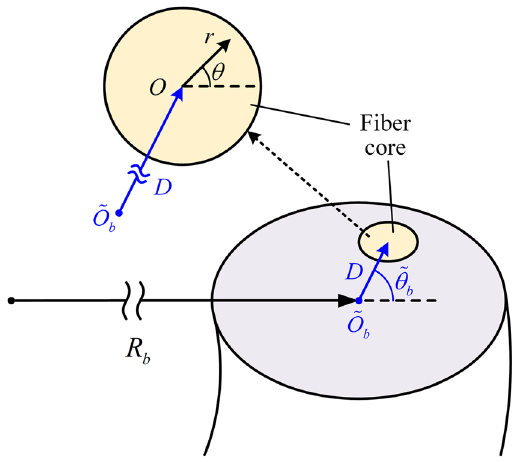
, θ  ) for the bent fiber is introduced. And b b . The radial direction is b ), which is the origin O of b